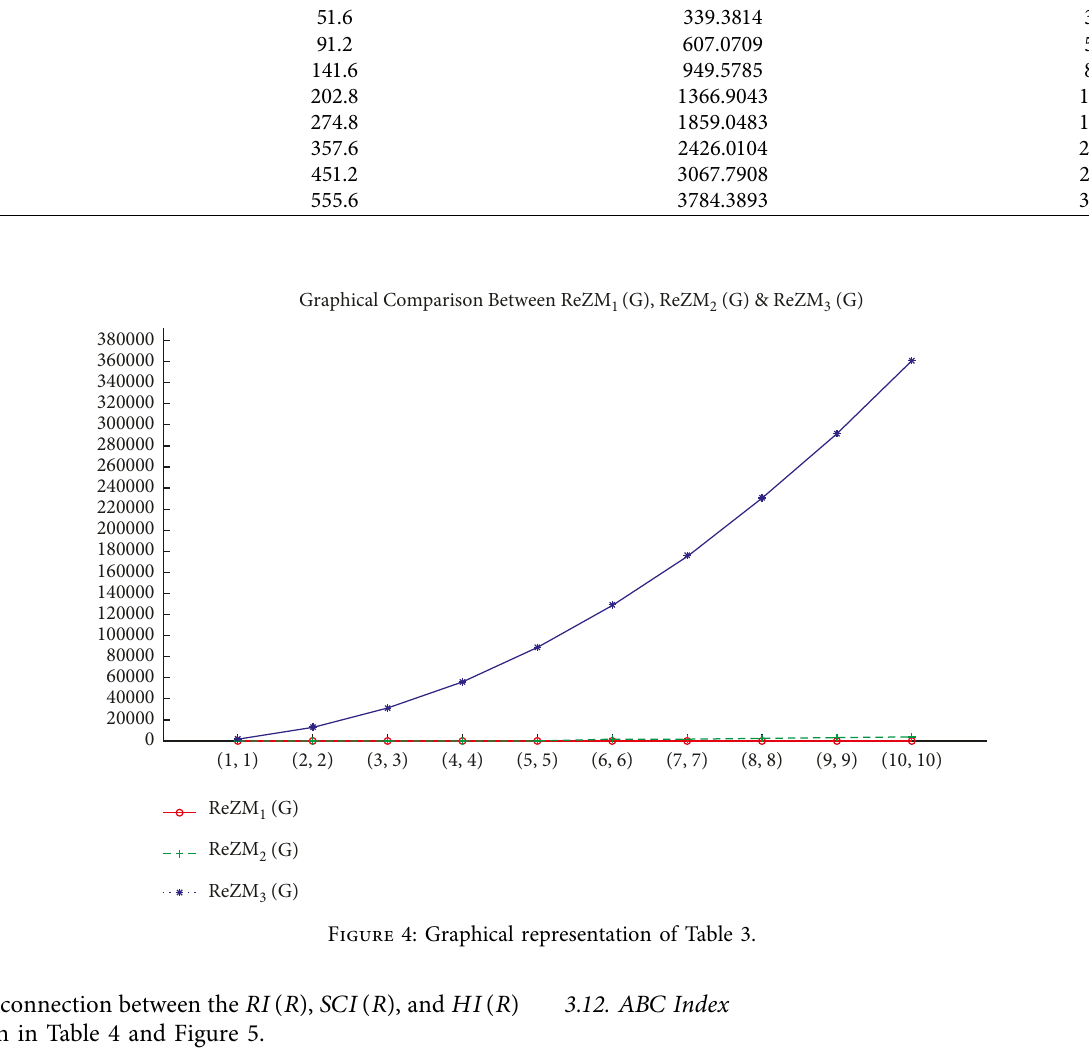
Table 3: Connection between Re ZG